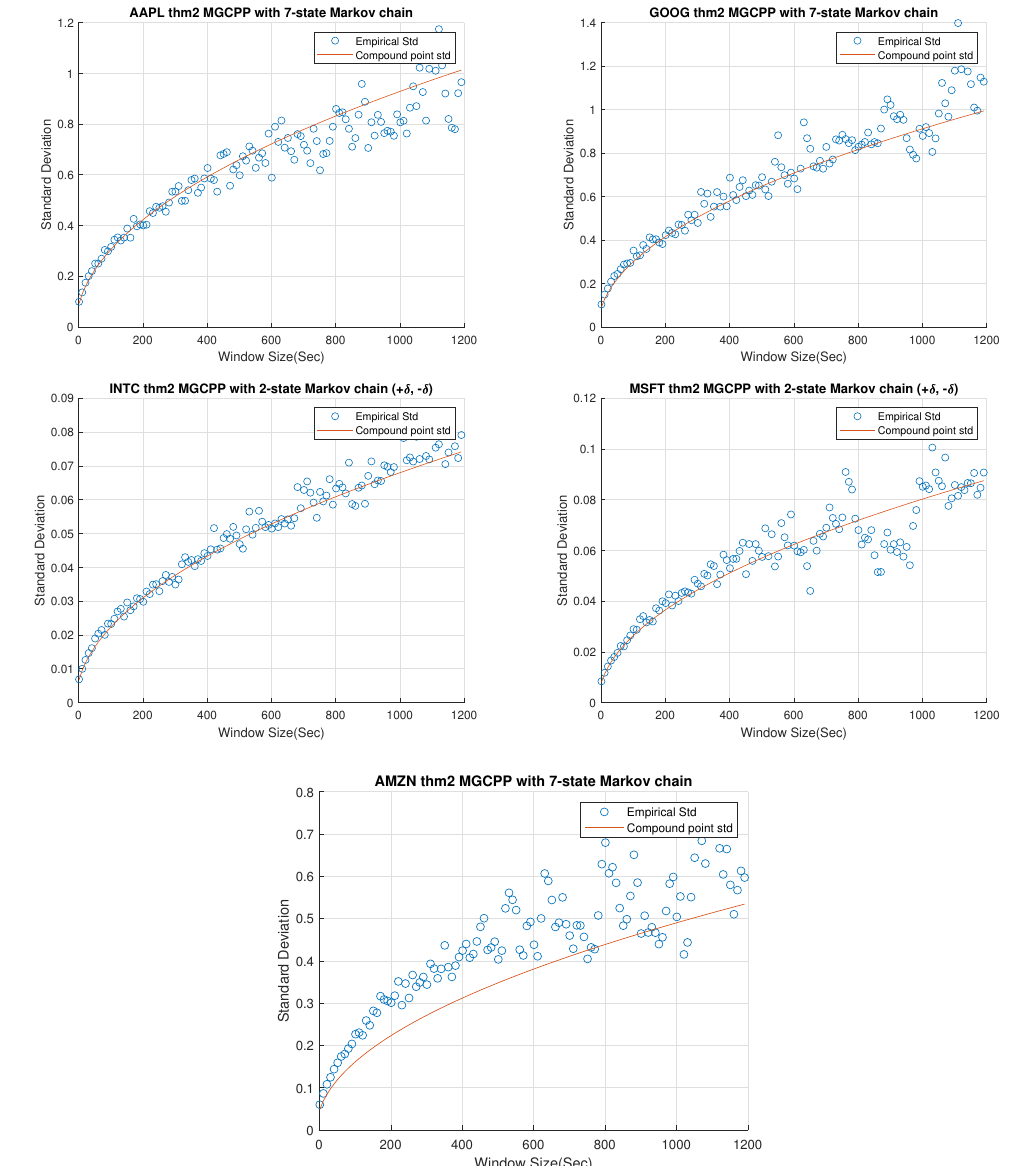
Figure 5. Standard deviation comparisons for 5 stocks by FCLT II for the MGCPP. INTC and MSFT are simulated with 2-state Markov chain while AAPL, AMZN, and GOOG are using 7-state Markov